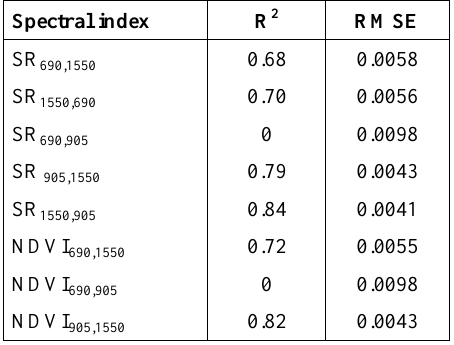
Table 2. Coefficients of determination (R2) and root mean square error (RMSE) for the linear regression models between spectral indices and EWT.